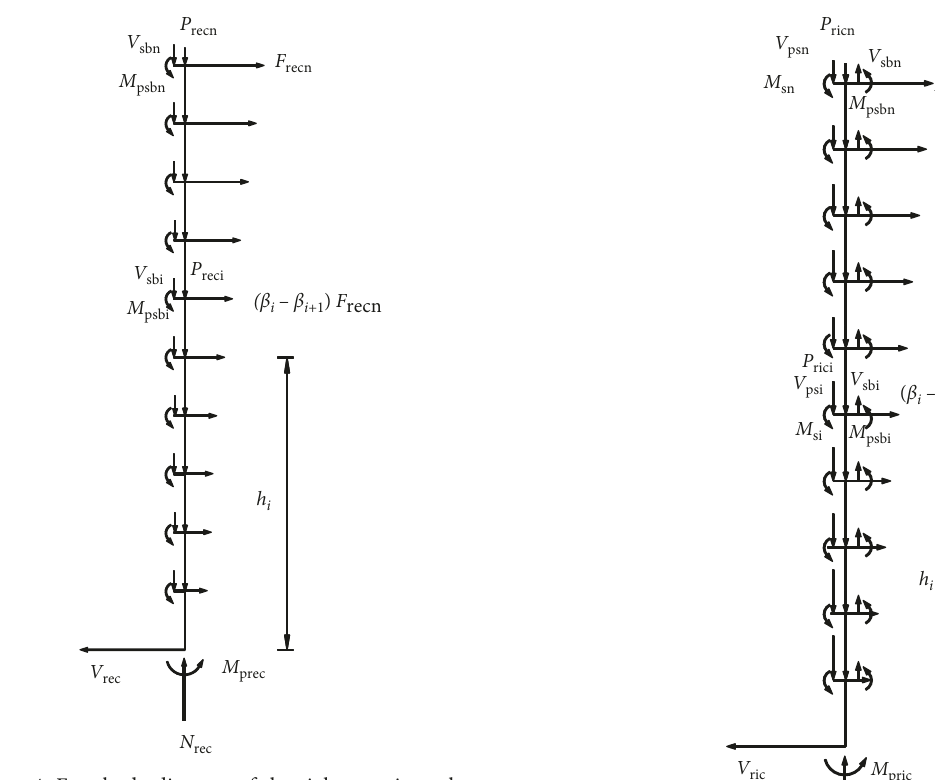
Figure 4: Free body diagram of the right exterior column.